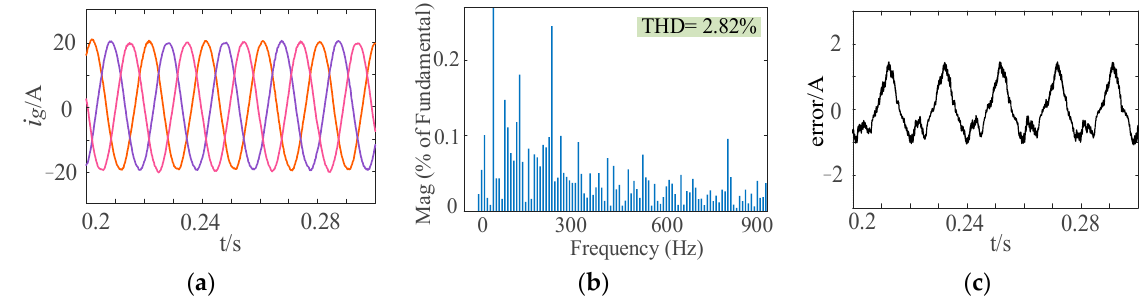
Figure 15. Simulation results of CPRRC at 50.8 Hz: ( a ) Grid current i g . ( b ) Harmonic spectrum of i g_c . ( c ) Current tracking error ɛ .